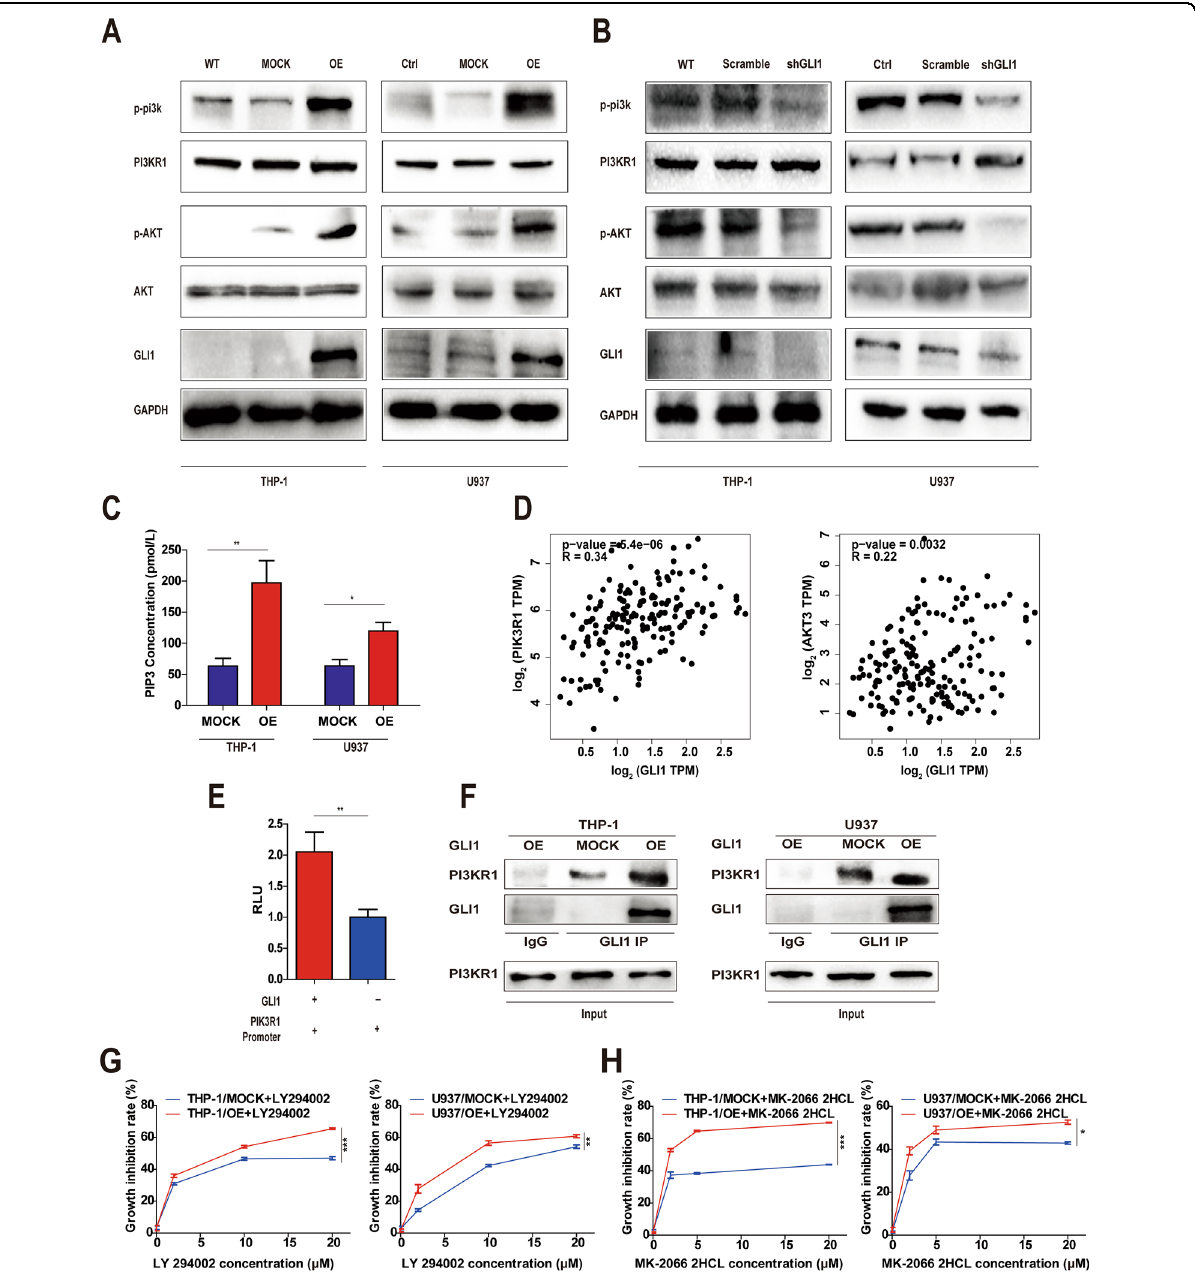
Fig. 3 GLI1 activates the PIK3R1 reporter and promotes GLI1-PIK3R1 binding. A , B The phosphorylation levels of PI3K and AKT in THP-1 and U937 cells with stable GLI1 overexpression and stable GLI1 knockdown. GAPDH was used as a loading control. WT, wild-type cells without treatment. C PIP3 levels in THP-1 and U937 MOCK/OE cells. D Correlations between GLI1 and PIK3R1 and GLI1 and AKT3 in AML patients were evaluated using a non-log scale for calculation and a log-scale for visualization. E The ability of PIK3R1 to activate the GLI1 reporter was assessed in 293 T cells. As a control, transcriptionally inactive GLI1 was tested. F Western blot analysis of the PI3KR1 and GLI1 protein expression levels in THP-1 and U937 MOCK/OE cells (Co- IP). G, H The viability of THP-1 and U937 MOCK/OE cells treated with different concentrations of LY249002 or MK-2206 2HCL was determined by CCK8. P values were calculated by the two-tailed Student ’ s t -test and two-way ANOVA. * P < 0.05, ** P < 0.01, *** P <0.001, ns not signi fi